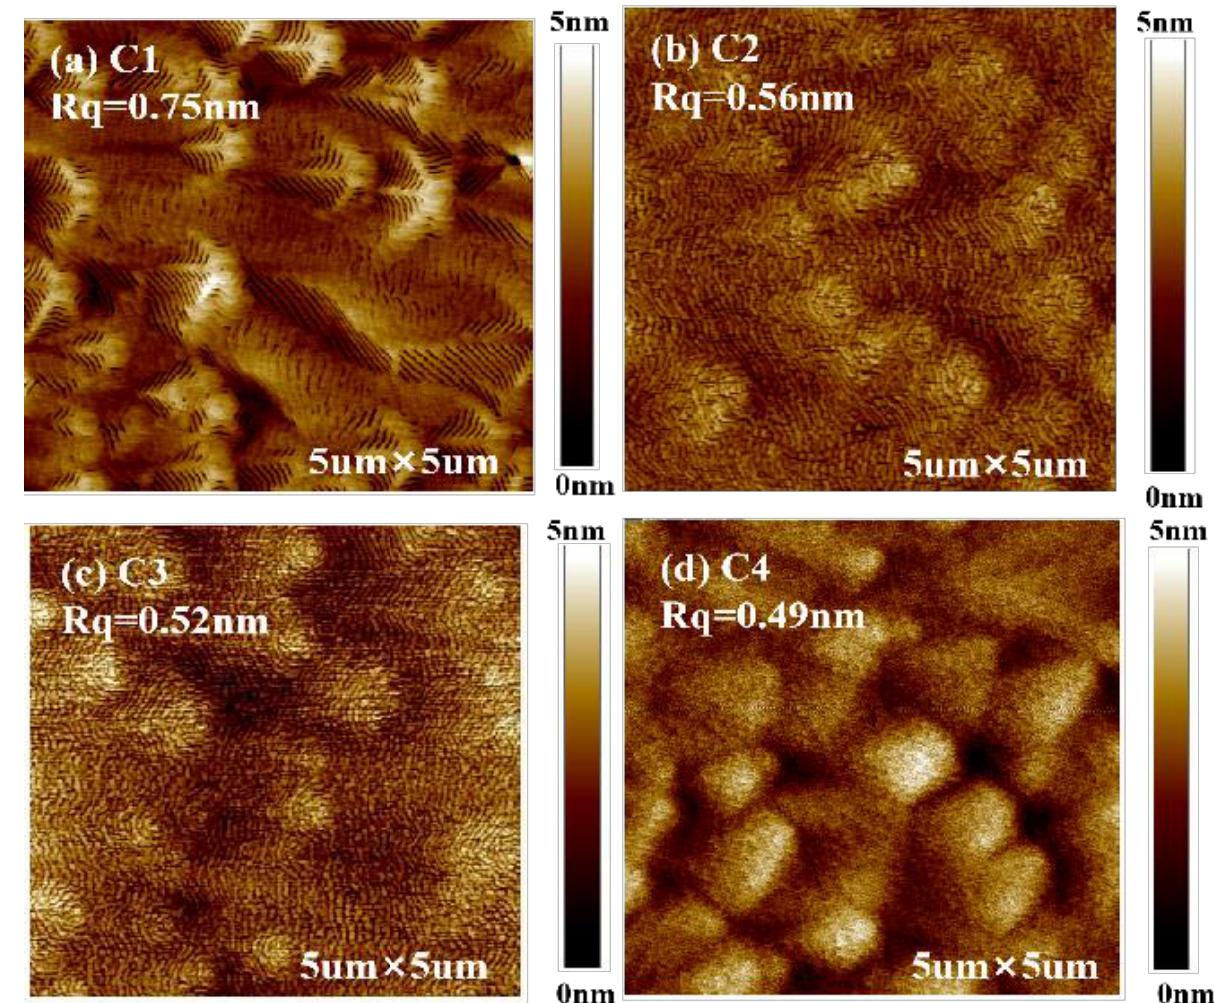
Figure 3. ( a – d ) are, respectively, 5 × 5 μm AFM images for sample C1, C2, C3 and C4. The corresponding periodic duty cyclings (open/close) of samples C1, C2, C3, and C4 are 6 s/3 s, 10 s/5 s, 20 s/10 s, and 40 s/20 s, respectively.